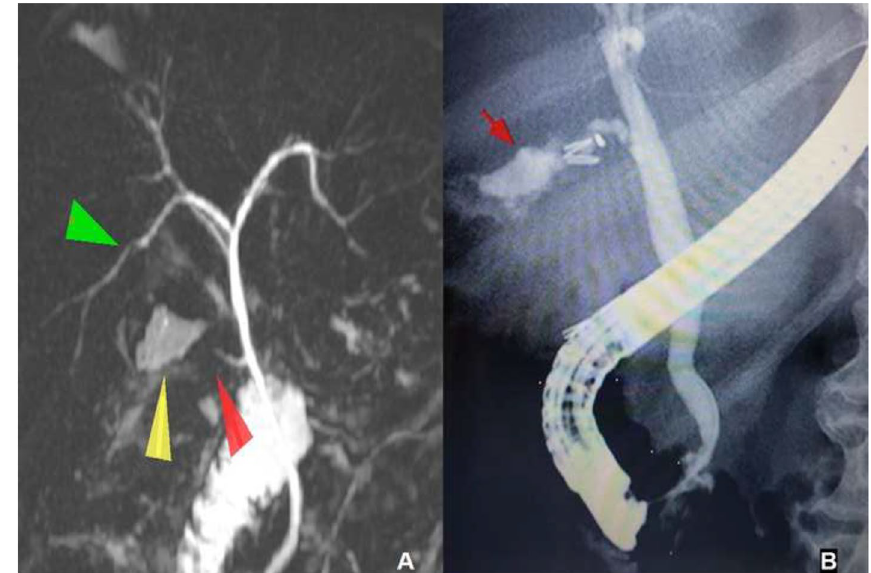
Fig. 9 3D-MRCP ( a ) Post-cholecystectomy small localized fluid collection “yellow arrowhead” at the gall bladder bed, near the cystic duct stump “red arrowhead”. Strasberg Type A bile duct injury. Aberrant right posterior hepatic duct joins the left bile duct “green arrowhead”. No intra-hepatic biliary radicles dilatation. ERCP image ( b ) demonstrates a collection in continuity with the cystic duct stump “red